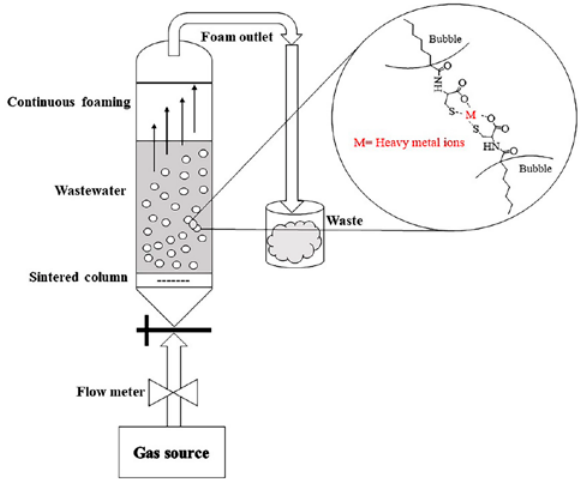
Figure 1. Schematic diagram of the batch ion flotation apparatus. Reproduced from